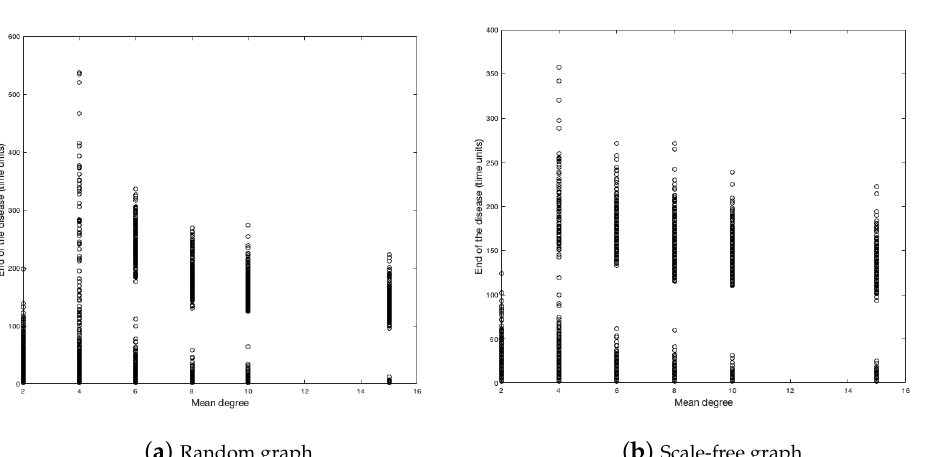
Figure 7. Duration of the disease in random and scale-free